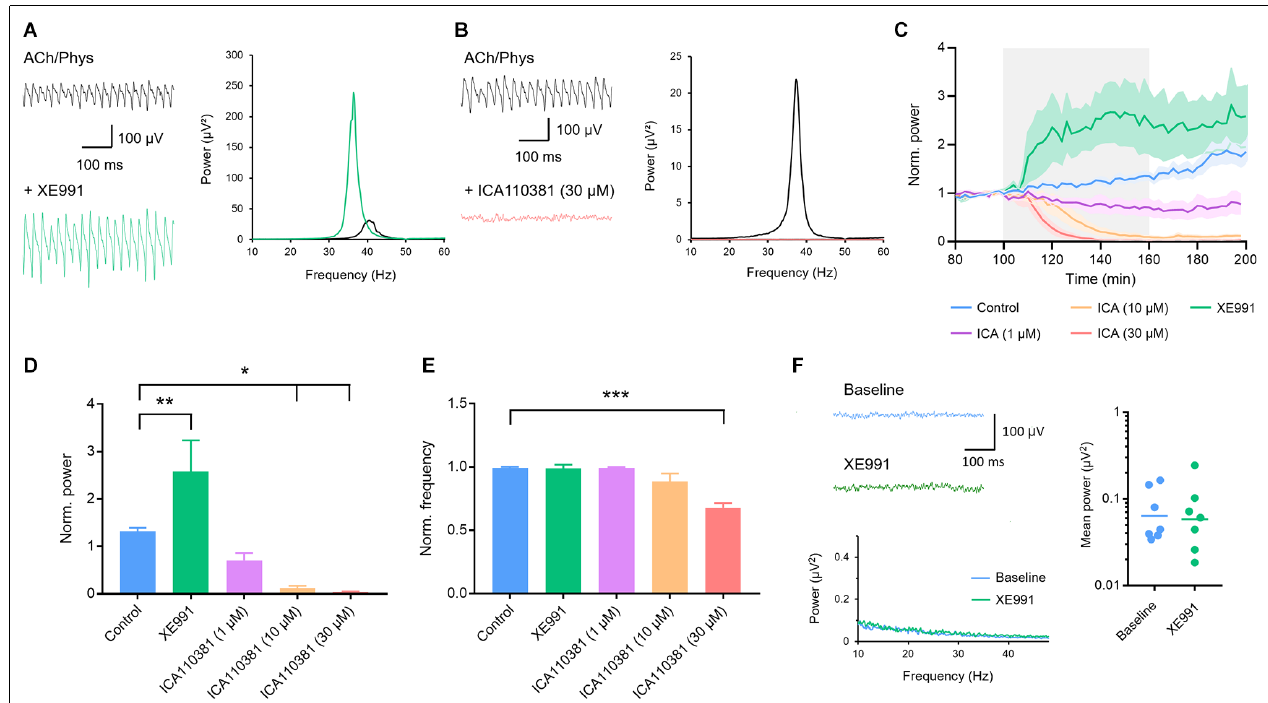
FIGURE 2 | Involvement of voltage-gated Kv7.2/3 (KCNQ2/3) channels in the modulation of hippocampal gamma oscillations. (A) Original traces (left) and power spectra (right) of cholinergically induced gamma oscillations before (black) and after (green) bath application of the KCNQ2/3 blocker XE991 (10 µ M). (B) Original traces (left) and power spectra (right) of cholinergically induced gamma oscillations before (black) and after (red) bath application of the KCNQ2/3 positive allosteric modulator ICA110381 (30 µ M). (C) Normalized gamma power before, during and after the application of XE991 (10 µ M, green) and increasing concentrations of ICA110381 (1 µ M; purple; 10 µ M; orange; 30 µ M red) compared to control (blue). The application of the drugs is highlighted in gray. (D) Effect of XE991 and ICA110381 on the normalized peak power of hippocampal gamma oscillations compared to control. Control (blue): n = 13 slices, N = 9 animals; XE991 (green): n = 9, N = 4, p = 0.009; ICA110381 1 µ M: (purple): n = 8, N = 5, p = 0.381; 10 µ M (orange): n = 8, N = 4, p = 0.019; 30 µ M (red): n = 8, N = 4, p = 0.011. (E) Effect of XE991 and ICA110381 on the normalized peak frequency of hippocampal gamma oscillations compared to control. XE991 (green): p > 0.999; ICA110381 1 µ M (purple): p > 0.999; 10 µ M (orange): p = 0.073; 30 µ M (red): p < 0.001. (F) Left, top: original traces of local field potentials (LFPs) before and after the application of XE991. Left, bottom: power spectra of LFPs before and after XE991 application. Right: scatter plot comparing the mean absolute power between 10 and 50 Hz before (baseline; blue) and after application of XE991 (green, n = 7, p = 0.825, bars show geometric mean). Recording temperature was between 34 and 36 ◦ C. Traces were lowpass filtered at 200 Hz and bandstop-filtered at 50 Hz. Bars show mean ± SEM. * p < 0.05, ** p < 0.01, *** p < 0.001. ACh, acetylcholine; Phys,